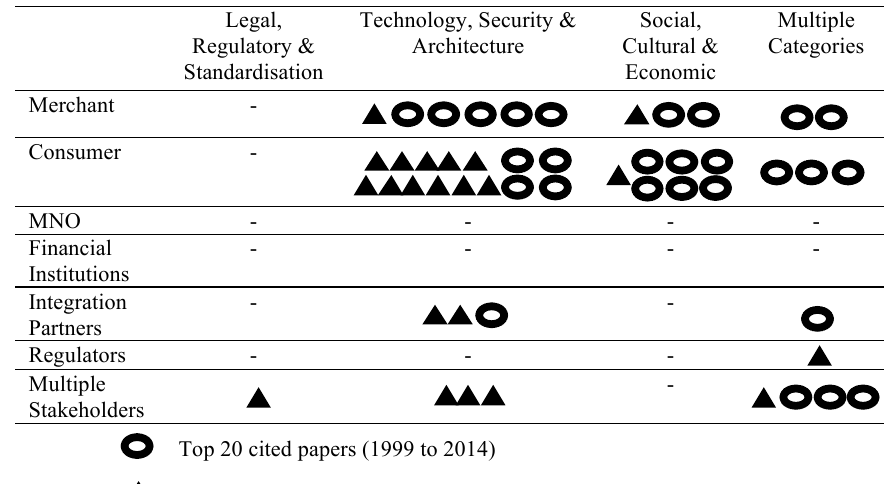
Table 7. Main focus of the theoretical and empirical